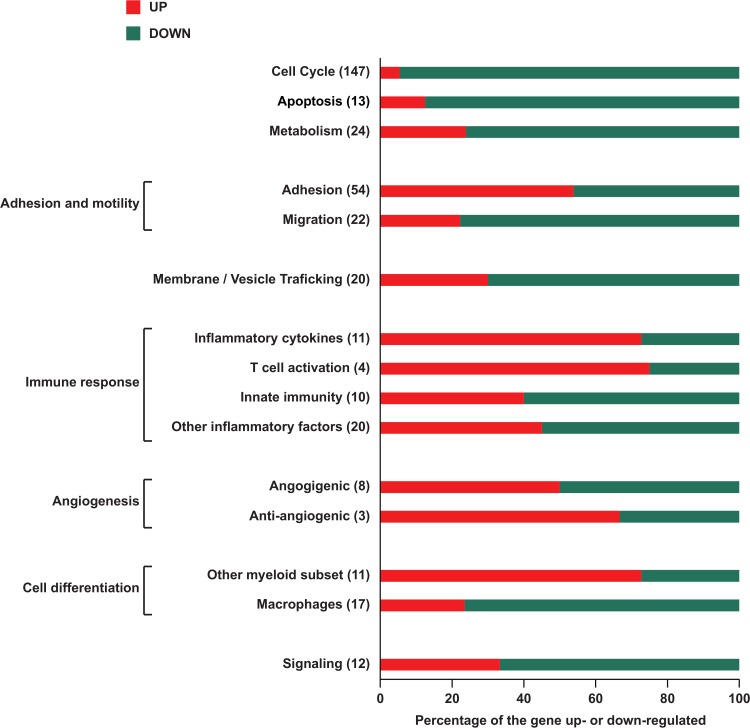
Gene expression changes in monocytes treated with TGF-β/ANG-2 and TGF-β/PlGF relative to untreated and VEGF/TNF-α cells.398 significantly (P ≤ 0.05) differentially expressed genes were manually annotated and classified in categories (S5 Table). In each category the percentage of up- and down-regulated genes are displayed as well as the total number of genes (under brackets). 50 genes could not be assigned to these categories.